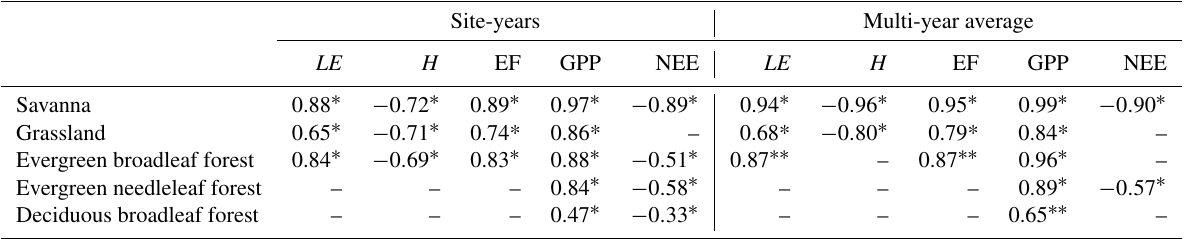
Table 2. Strength and significance of the correlation between the LAI and surface fluxes for site-year and multi-year average data. The correlation coefficients are shown for significant correlations at ∗ p ≤ 0 . 05 or at ∗∗ p ≤ 0 . 1. “–” indicates that the correlation was not